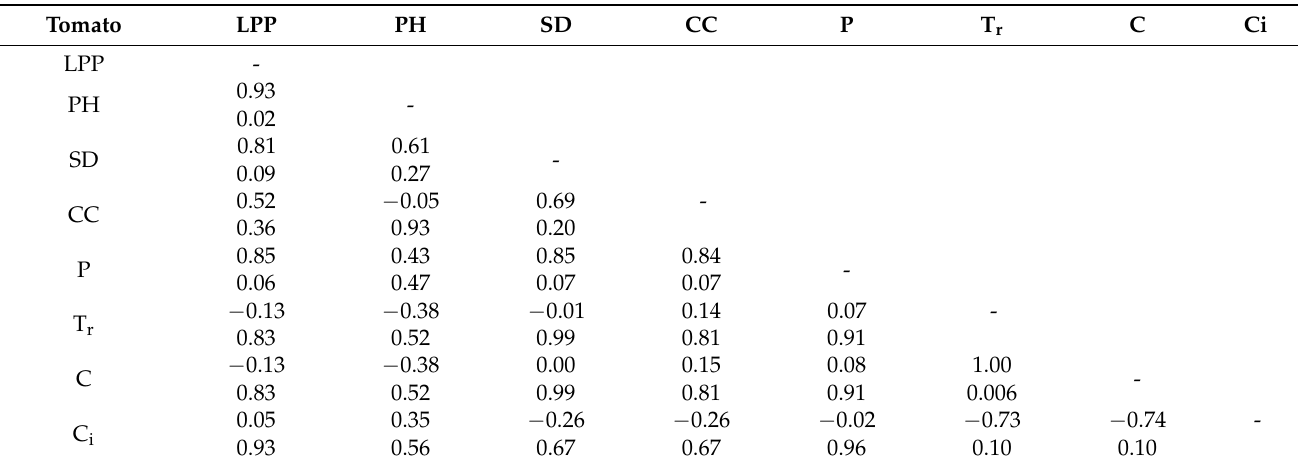
Table 1. Pearson correlation coefficient (upper value) and p -value (lower value) for the tomato- infested host